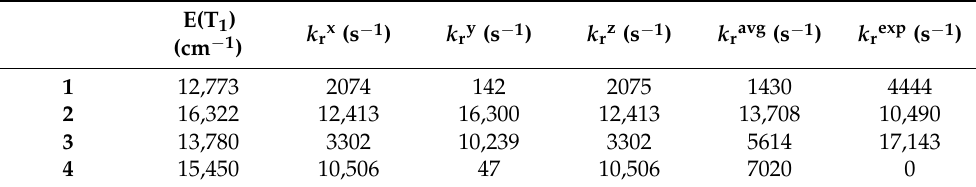
Calculated excited triplet energy E (T 1 ) and k r based on the T 1 geometry by